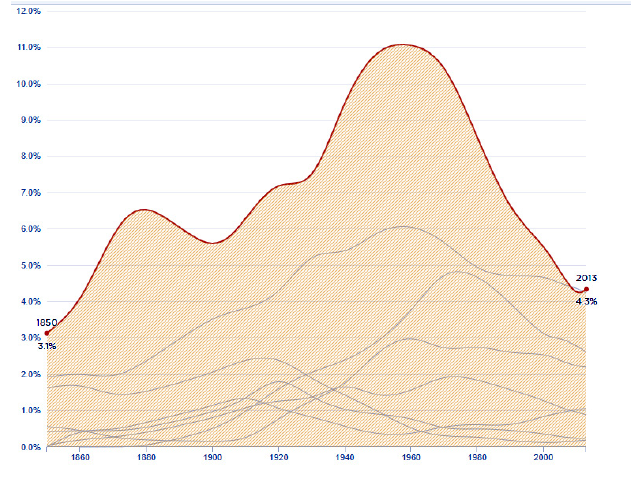
Figure 2. Demand for factory